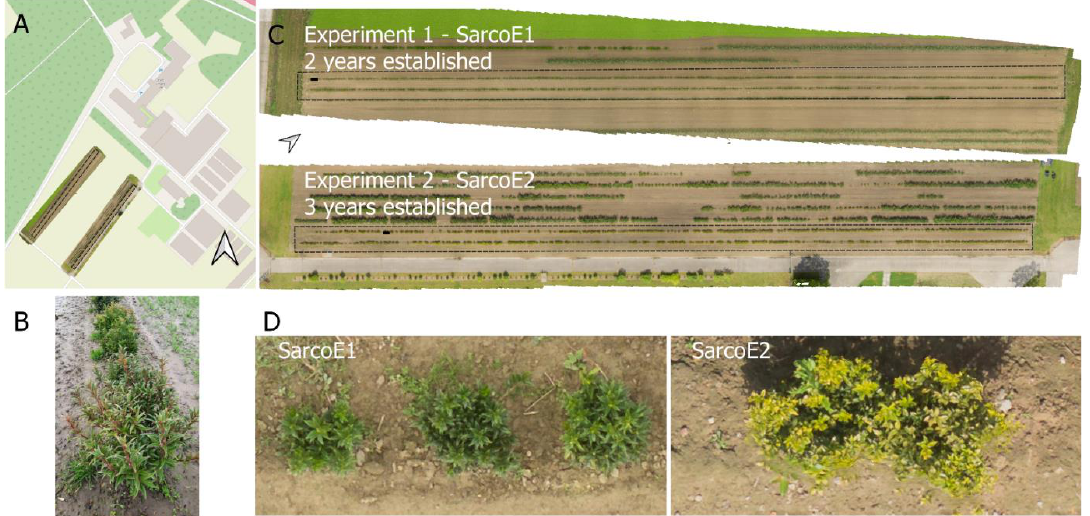
Figure 1. ( A ) Location of the two Sarcococca trials; ( B ) Sarcococca plants in the field; ( C ) SarcoE1 and SarcoE2 indicated with black dashed lines; and ( D ) close-up of the established plants (from the location marked in C with a black rectangle).